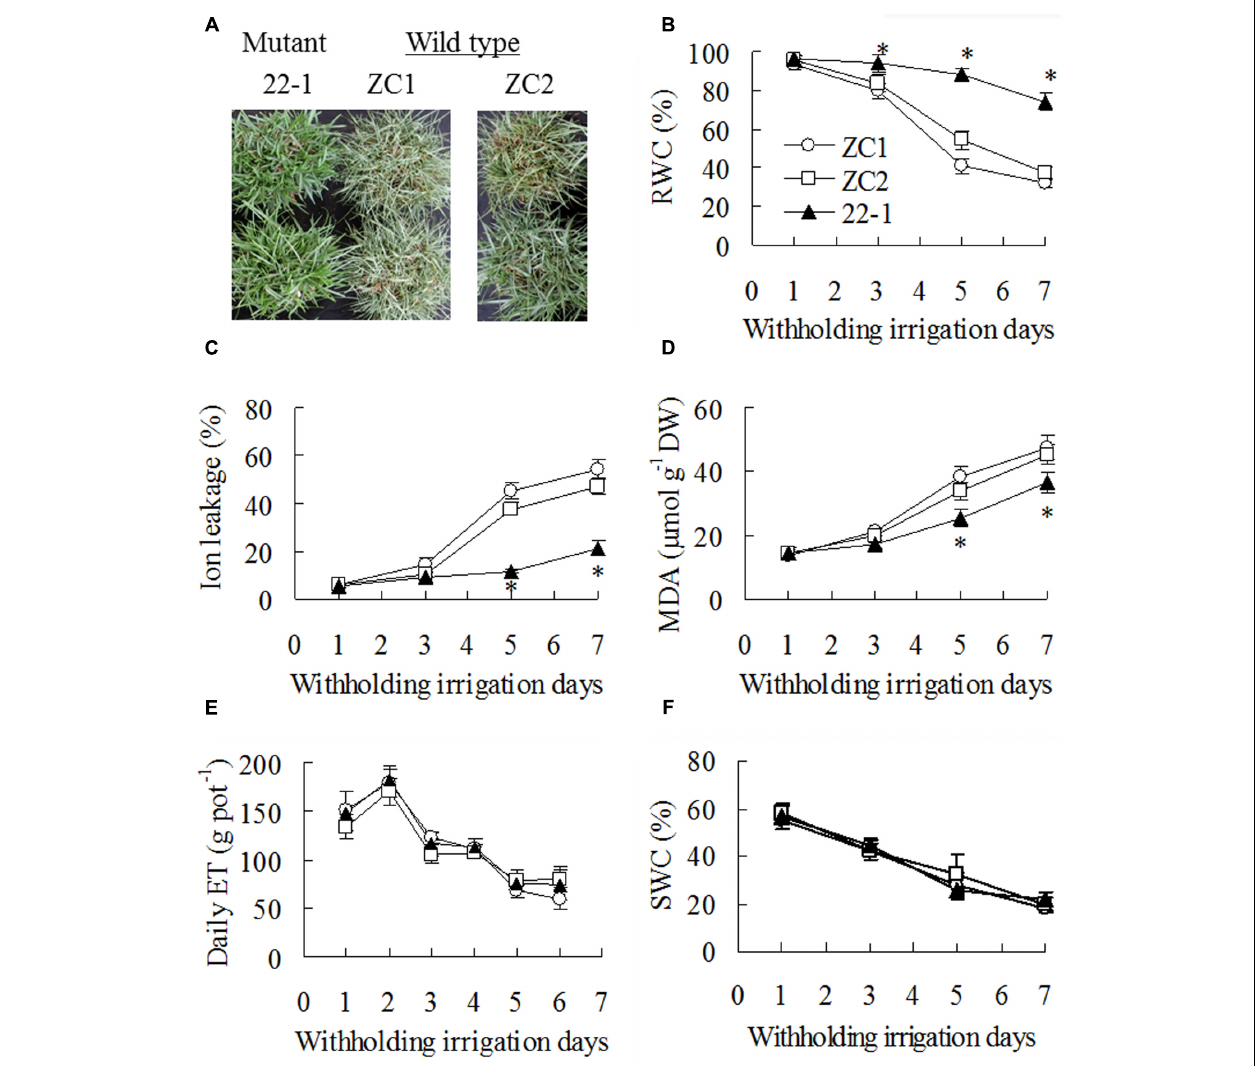
FIGURE 1 | Assessment of drought tolerance in the mutant 22-1 in comparison with two wild type plant lines (ZC1, ZC2). Photography was taken after 7 days of withholding irrigation (A) . Relative water content (RWC, B ), ion leakage (C) , malondialdehyde (MDA, D ), daily evaporation (ET, E ), and soil water content (SWC, F ) were measured at the dates as indicated in the figures. Means of three pots of plant samples and the standard errors are presented; an asterisk indicates significant difference between 22-1 and the wild types at P < 0.05 at a given time.